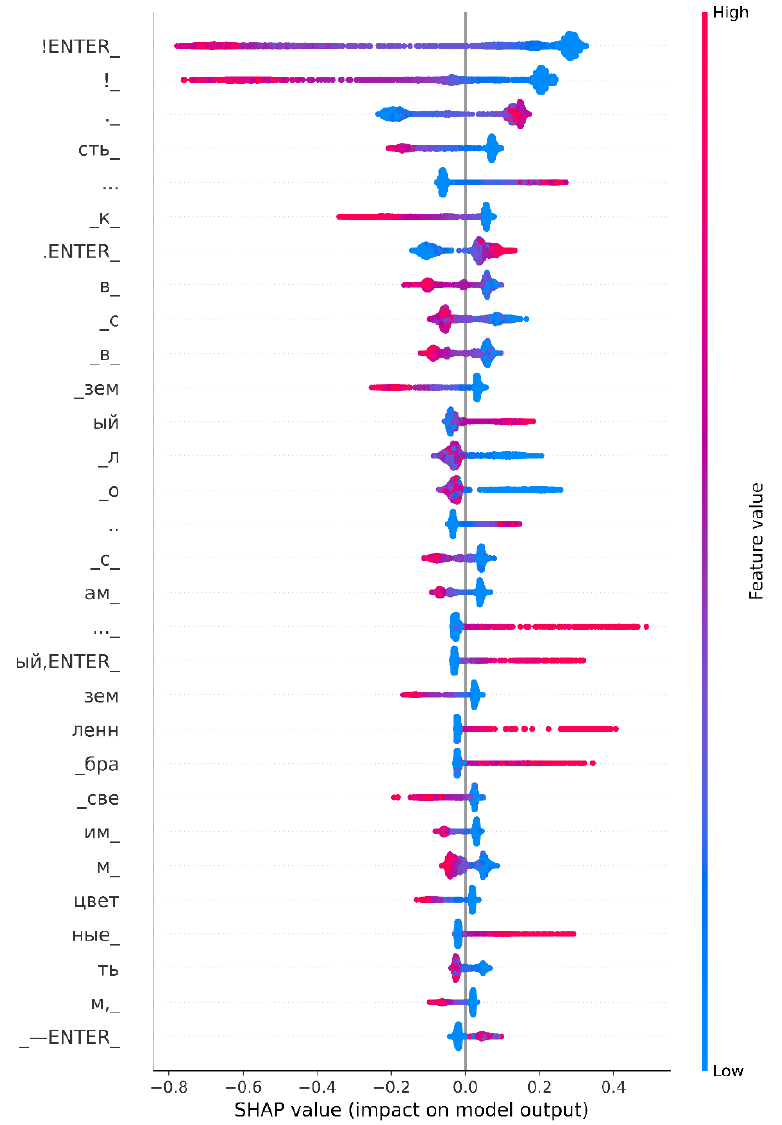
Figure 4. Distribution of the influence of the features on the results of classification by 2, 3 and 4g.